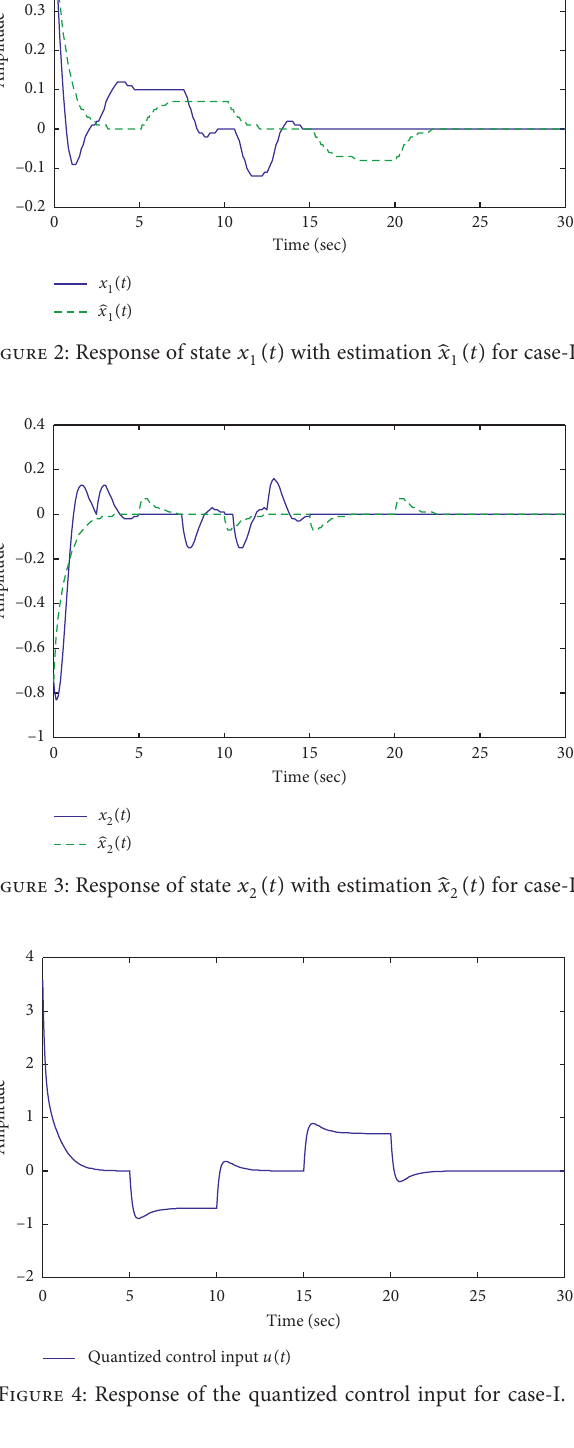
Figure 4: Response of the quantized control input for